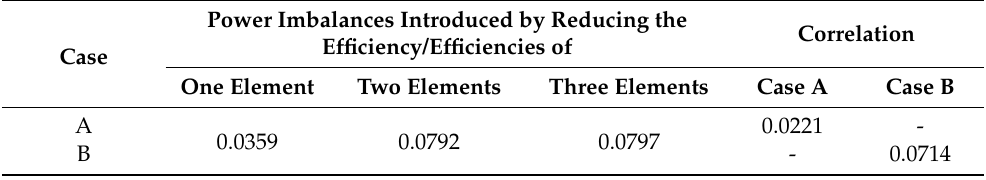
Figure 1. SM efficiency as a function of power-imbalance in 4 × 4 MIMO systems. ( a ) Power imbal- ance is introduced by reducing the efficiency of one element; ( b ) power imbalances are introduced by reducing the efficiencies of two elements to different values. The results are applicable to both case A and case B.